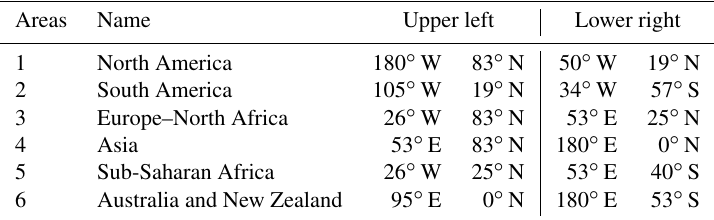
Table 1. Geographical distribution of BA tiles for the pixel product.